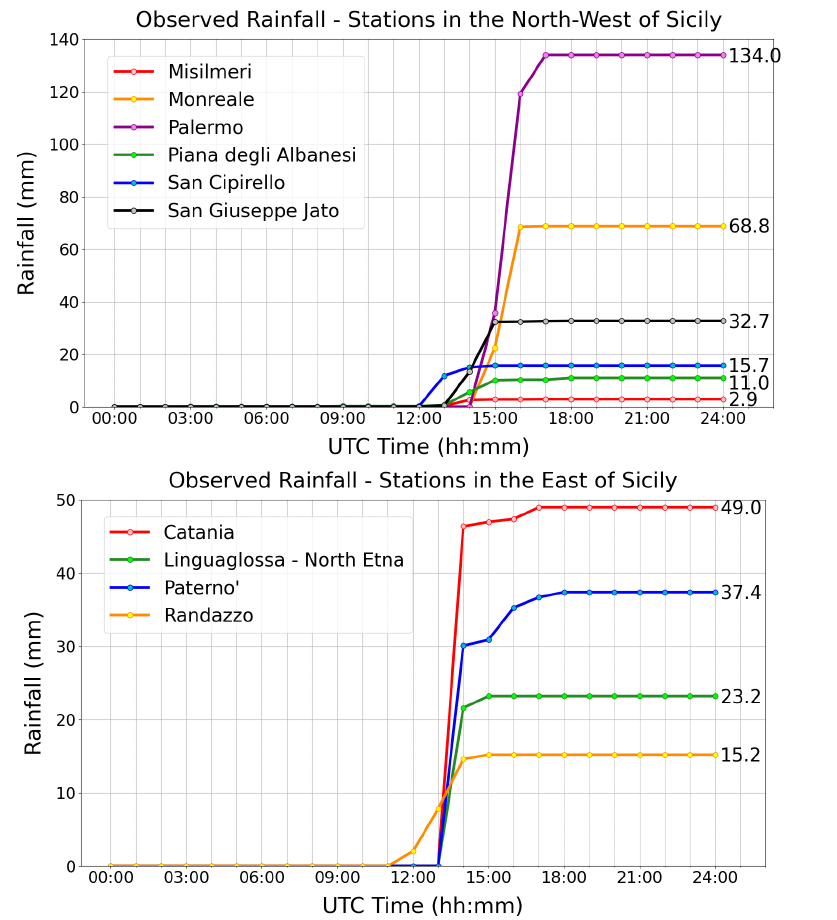
Figure 23. Cumulative rainfall observed during the whole day of 15 July 2020, in correspondence of six stations placed in the northwestern part of Sicily ( top ) and of four weather stations placed in the eastern part of Sicily ( bottom